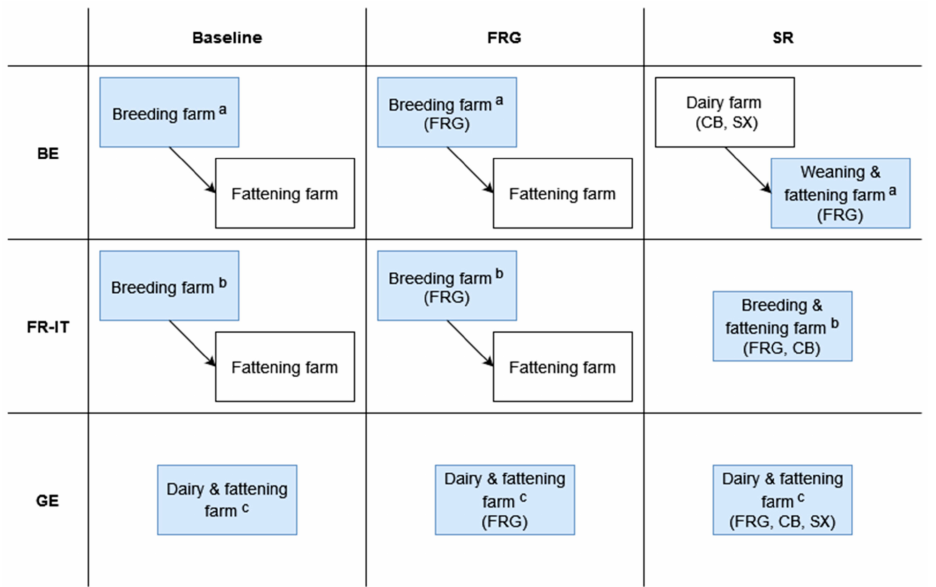
Figure 1. Overview of the beef production system considered in the study and the associated scenarios (baseline, fast rotational grazing (FRG), and system redesign (SR)). In the SR scenario, crossbreeding (CB) and sexing (SX) are applied in dairy farms. The farms of interest, labeled a in Belgium, b in France, and c in Germany (in blue), is the farm in which the tested innovation take place. Farm-level indicators, such as the profit, are computed for this particular